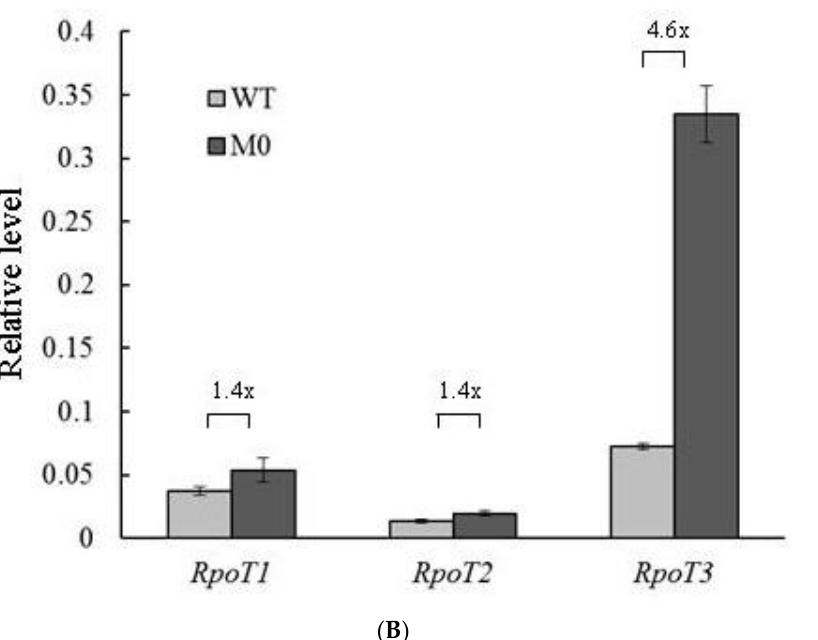
Figure 5. The relative expression levels of nucleus-encoded RpoT genes between PEP-deficient tobacco and wild-type plants. ( A ). The relative RPKM analysis was used to measure the relative expression levels of nucleus-encoded RpoT ( RpoT1 , RpoT2 and RpoT3 ) genes by mapping the RNA-Seq reads from the leaf tissues of the PEP-deficient (M0) tobacco and wild-type (WT) plants to the corresponding templates using the CLC Genomic Workbench 10 with the parameters of L = 0.8 and S = 0.8. The RPKM of nuclear EF-1 α transcripts was used for normalization, set to 1. ( B ). A qRT-PCR assay with the gene-specific primers (Supplementary Table S1) was used to measure the relative levels of RpoT1 , RpoT2 and RpoT3 transcripts between the PEP-deficient (M0) tobacco and wild-type (WT) plants, with nuclear EF-1 α mRNA as a control. The qRT-PCR assay was carried out in triplicate. Data are means ±